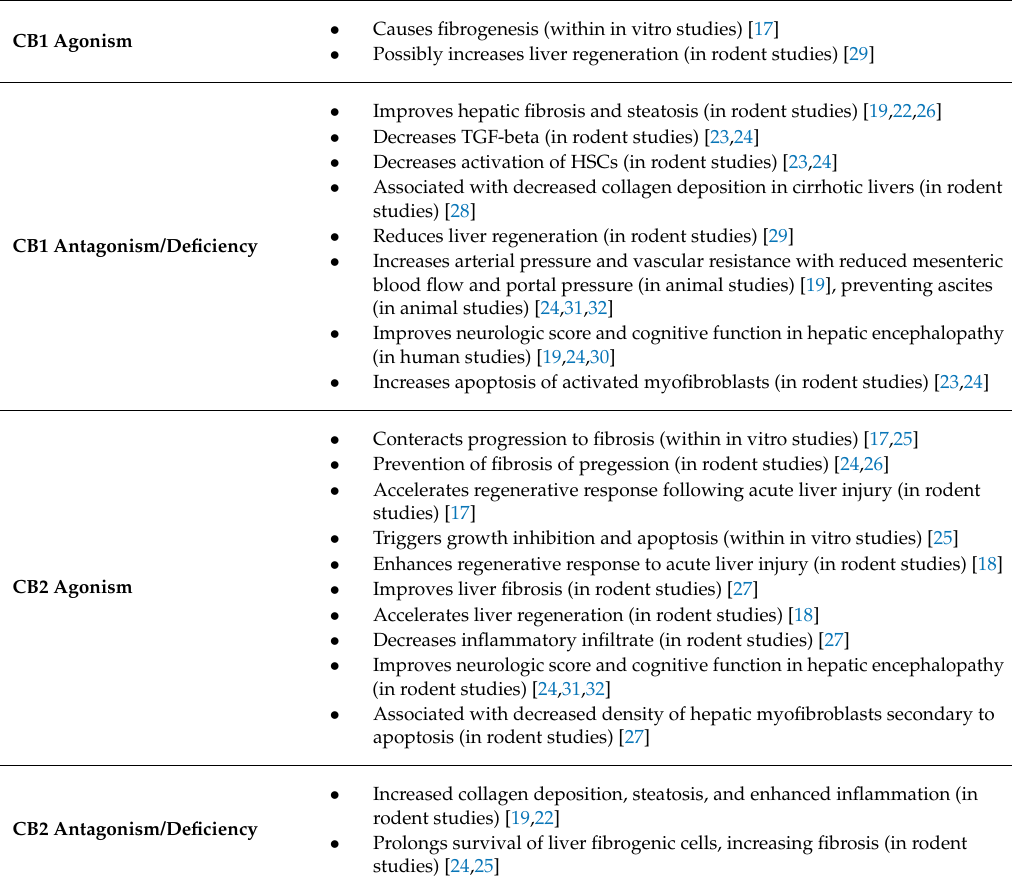
Table 1. Functions of Cannabinoid Receptors of the Endocannabinoid System in